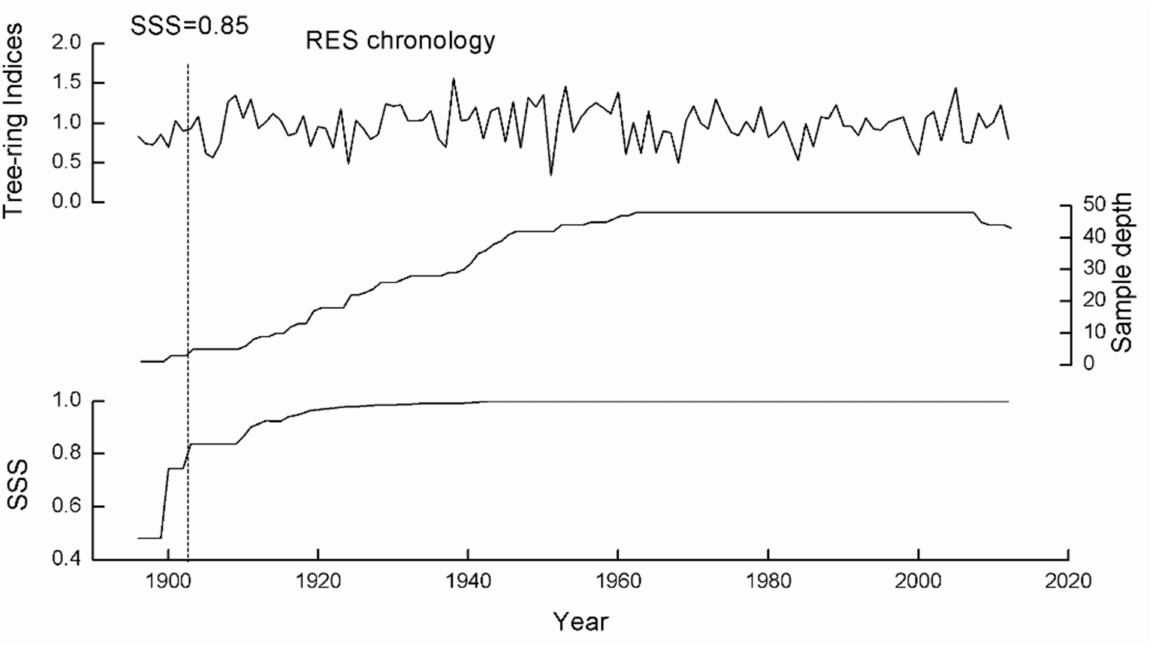
Figure 2. Tree-ring RES chronology, SSS and sample